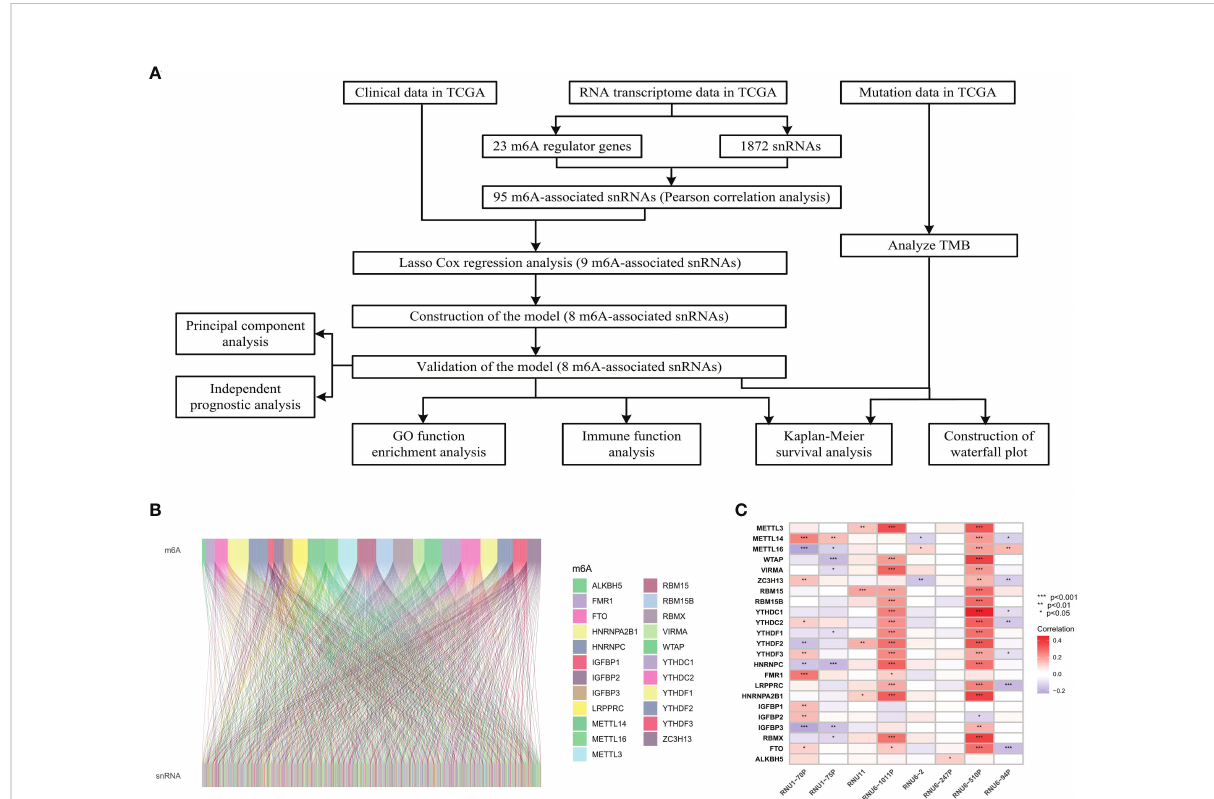
FIGURE 1 Flowchart and association analysis between m6A regulators and snRNAs. (A) Flowchart of this study. (B) Association between m6A RNA regulators and snRNAs. (C) Heatmap of prognostic snRNAs associated with m6A RNA